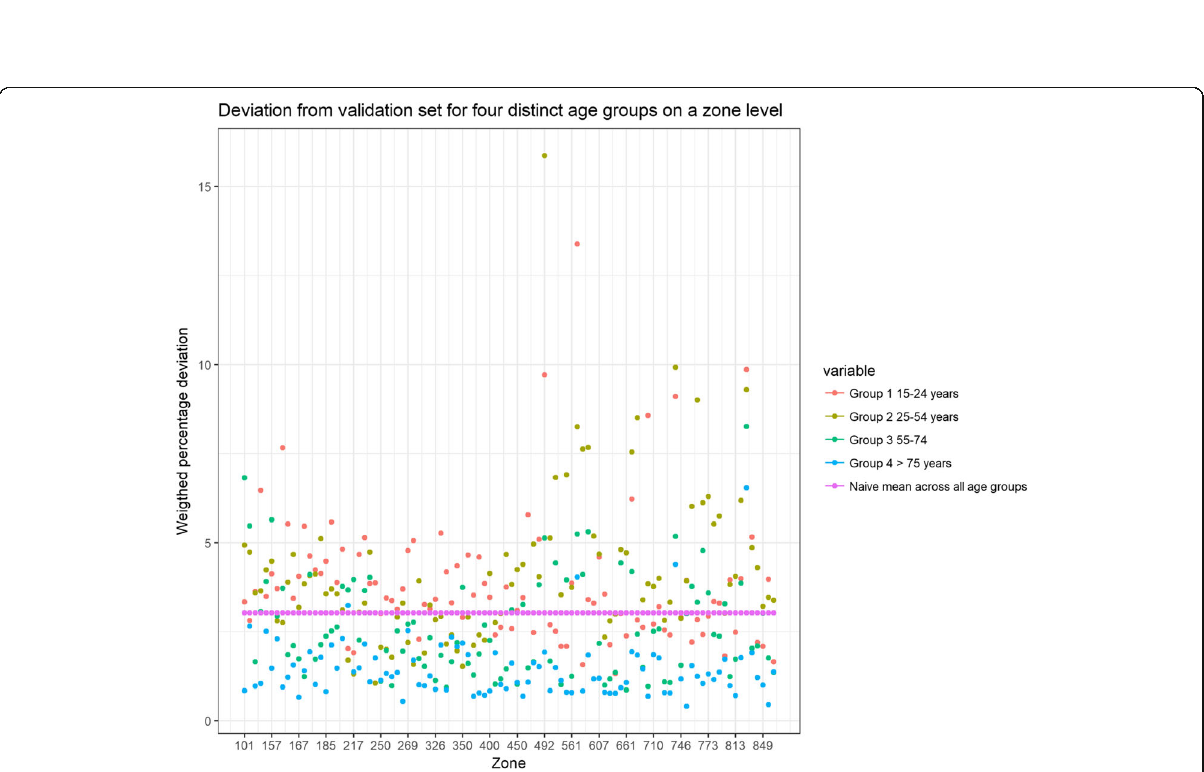
Fig. 8 Weighted percentage subzone deviation of predicted population by age groups from 2010 to